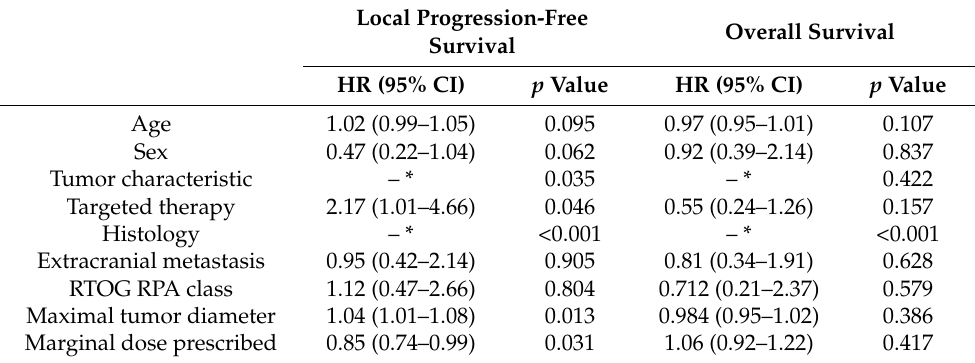
Table 2. Univariable Cox proportional hazards regression analysis of clinical